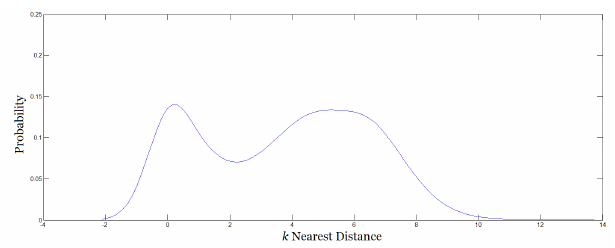
Figure 3. Probability Density Distribution of The k Nearest Distance.